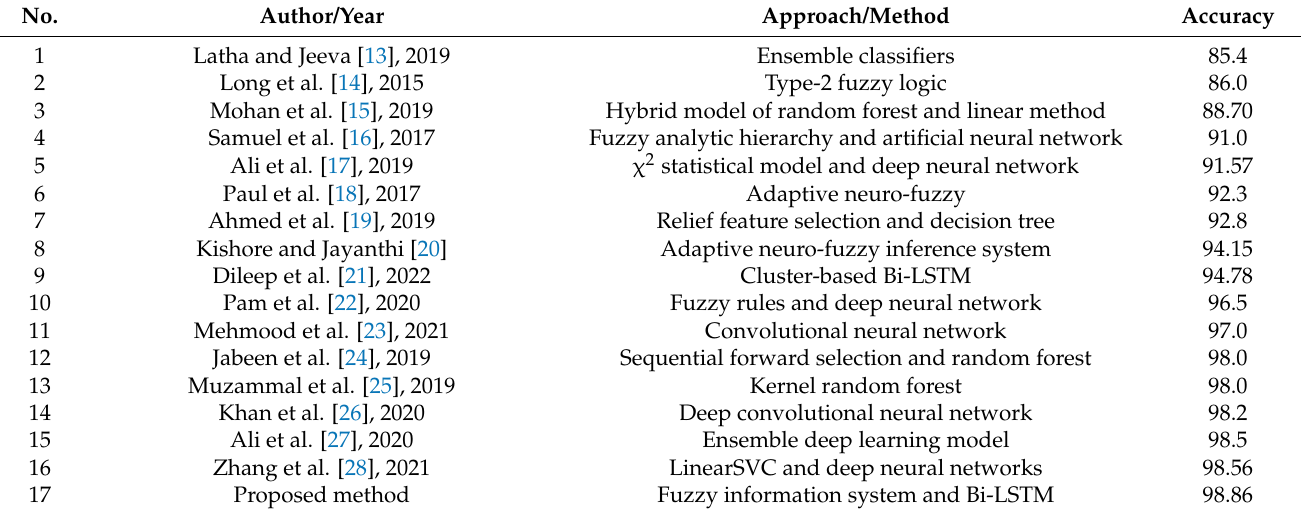
Table 7. Detailed comparison with the state-of-the-art